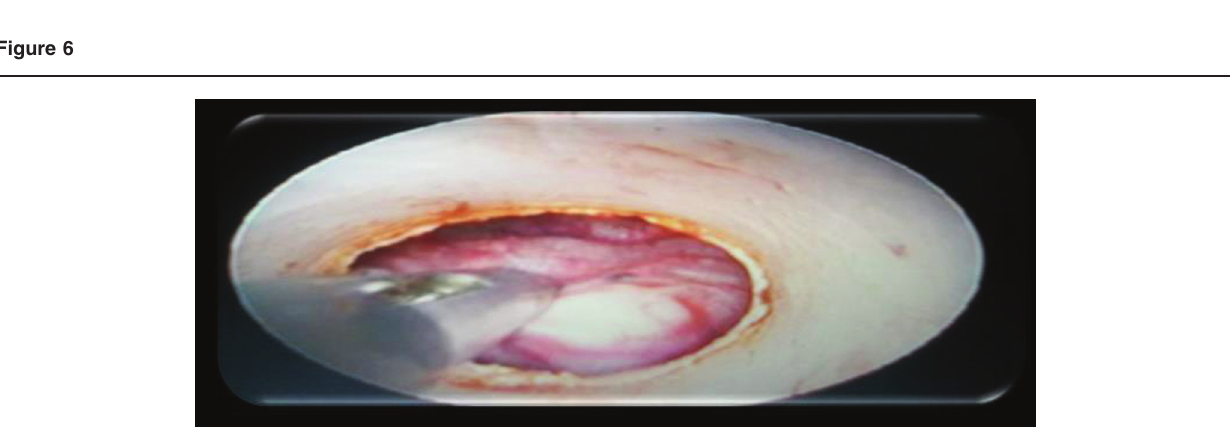
The biopsy forceps grasping the lung while taking the biopsy.